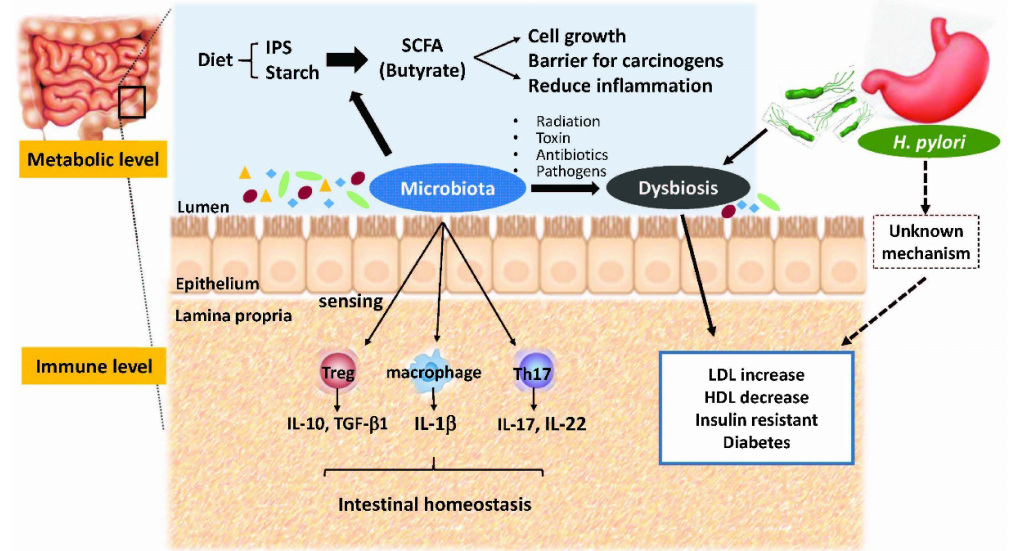
Figure 1. The metabolic and immunologic roles of gut microbiota and H. pylori infection on human metabolic disorders. IPS, indigestible polysaccharides; SCFA, short-chain fatty acid; LDL, low-density lipoprotein; HDL, high-density